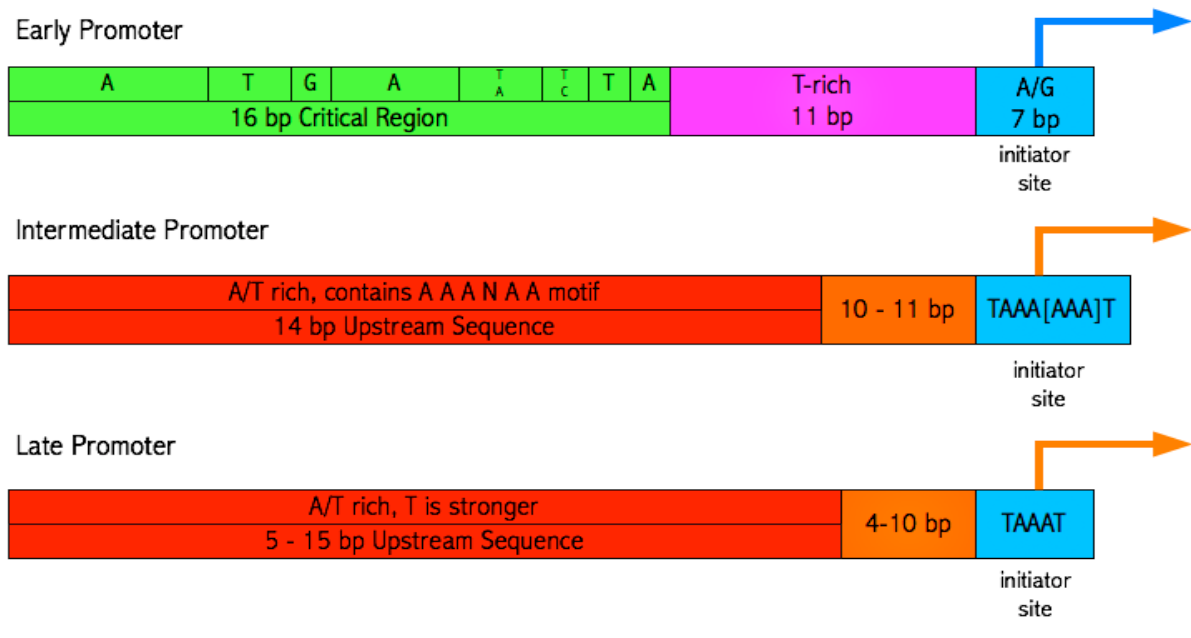
Figure 4. Known consensus of conserved poxvirus promoter